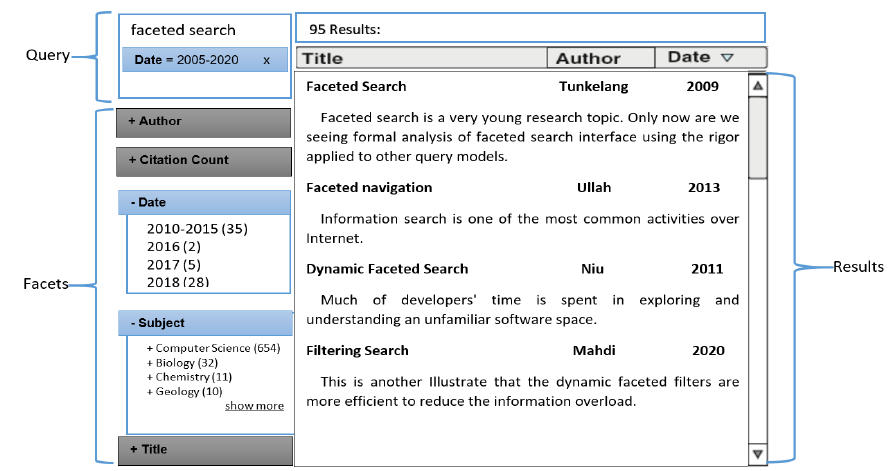
Figure 2. Faceted search, interface example, illustrating facet browsing, searching, and the tight coupling of the